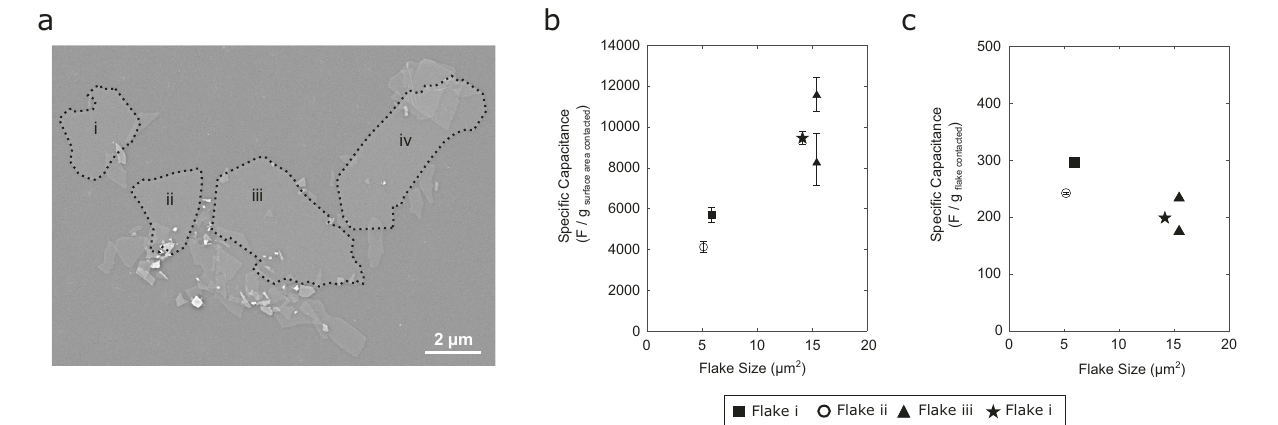
Fig. 3 | Monolayer MXene capacitive response dependence on fl ake size. a Electron micrograph of sample surface with fl akes larger than 5 μ m 2 labelled. b Speci fi c gravimetric capacitance on monolayer Ti 3 C 2 T x compared to the total area Ti 3 C 2 T x fl ake, obtained by normalizing capacitance by the mass of MXene in